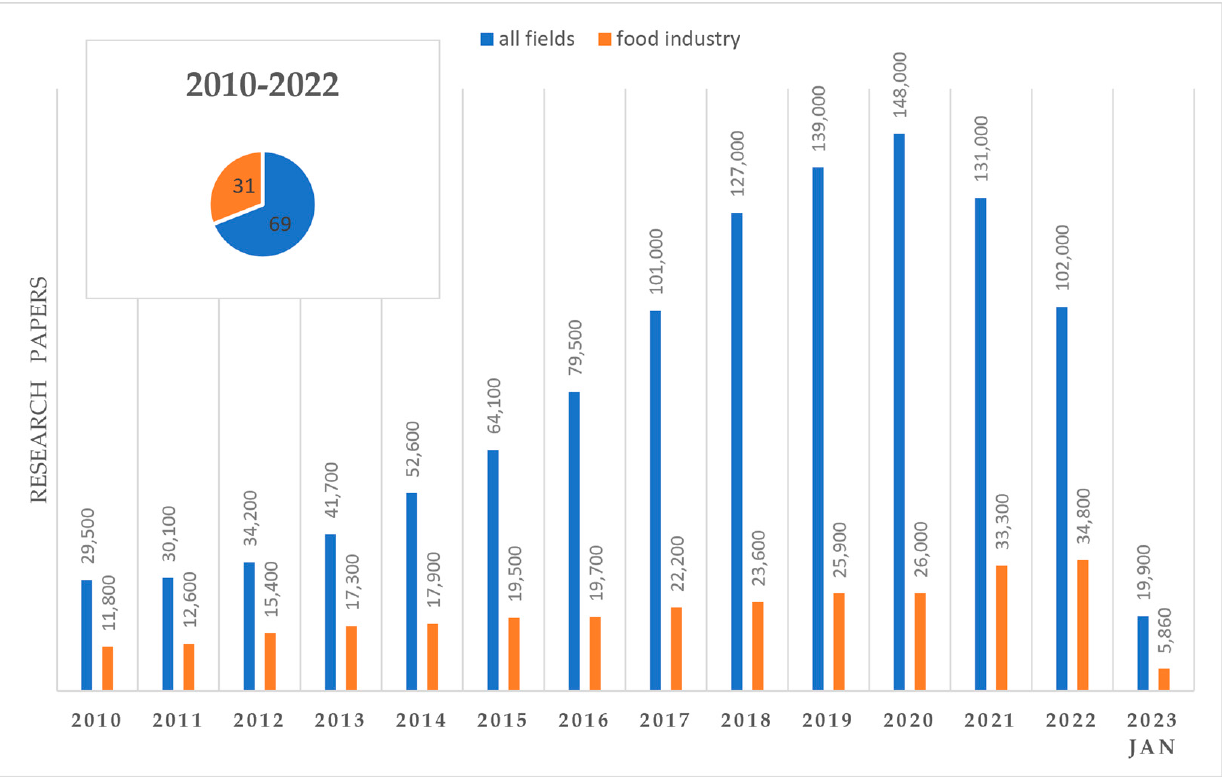
Table 1. Types of food products obtained with 3D technology. Food Product